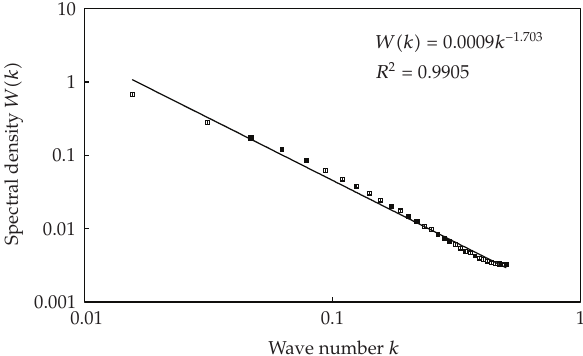
Figure 7: A log-log plot of the wave-spectrum relation of Beijing’s land use